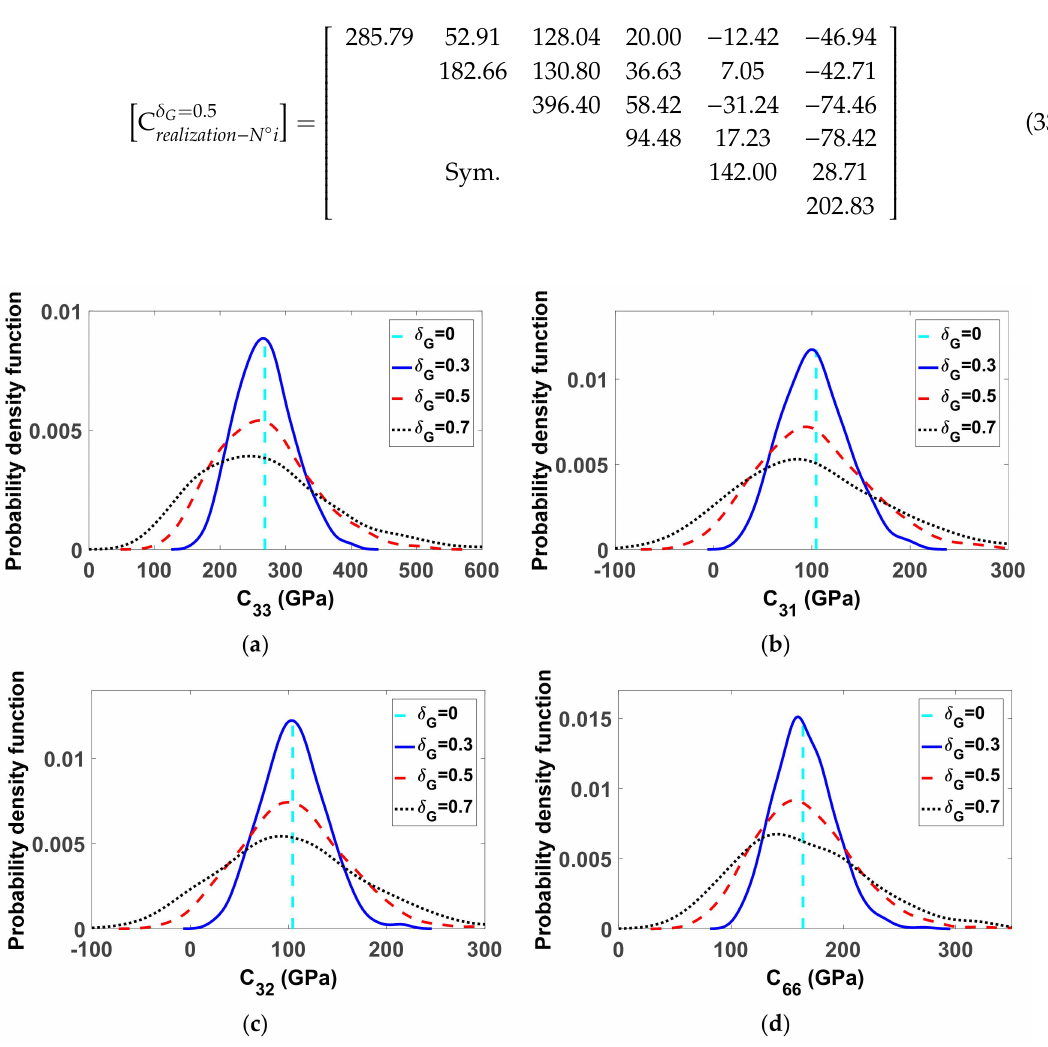
Figure 5. Probability density functions of several components of elasticity matrix over 500 random realizations for ( a ) C 33 , ( b ) C 31 , ( c ) C 32 and ( d ) C 66 (in GPa) associated to three levels of fluctuations respectively. Value of the corresponding mean model is also